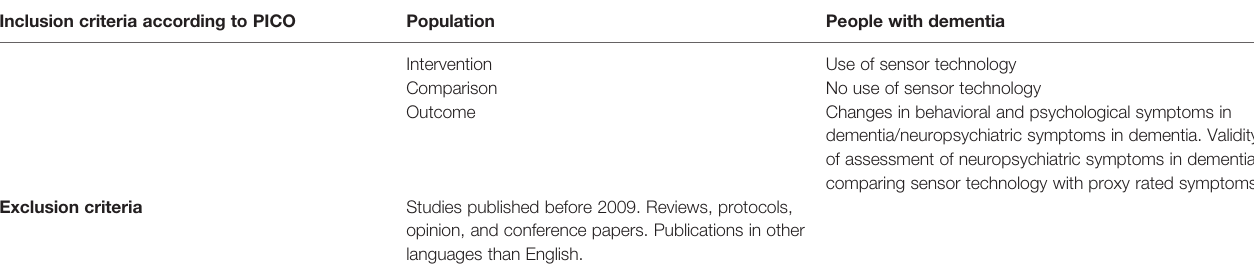
TABLE 1 | Inclusion and exclusion criteria.